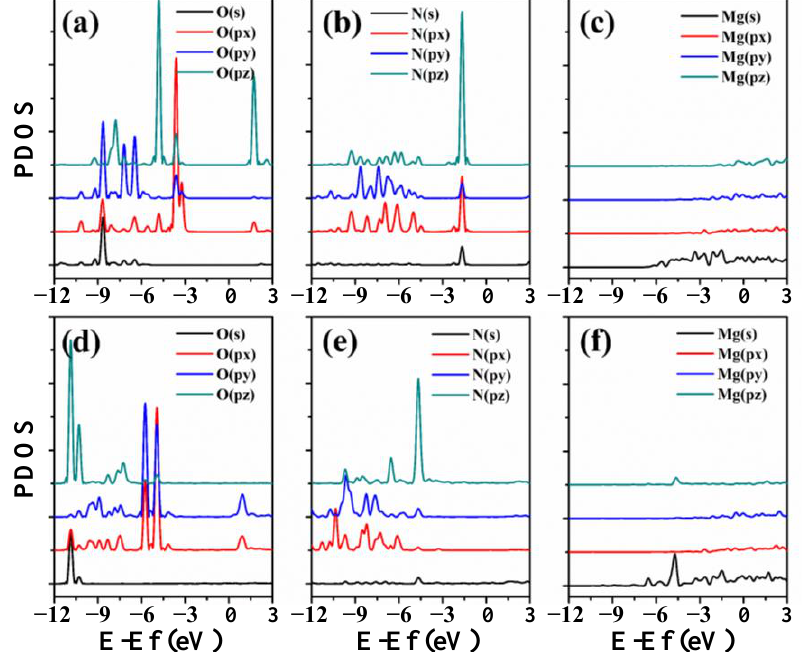
Figure 8. PDOS of the binding atoms on the Mg (1011) surface: ( a ) two O atoms, ( b ) two N atoms, and ( c ) four Mg atoms before adsorption; ( d – f ) are the PDOS of the corresponding atoms after adsorption. The energy zero is set to the Fermi level.